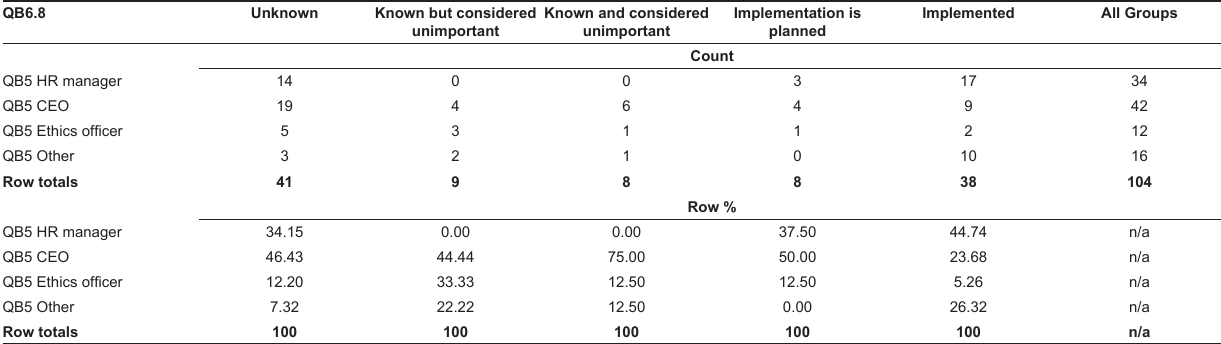
TABLE 12 Summary frequency QB6.8(5) × QB5(4): table Top management’s ethical leadership and who should be responsible for ethics in the organisation